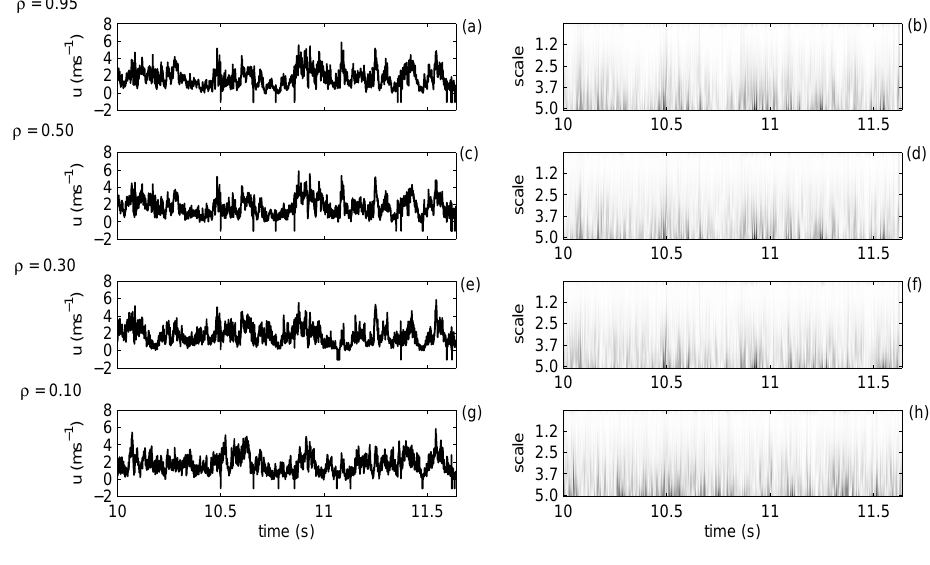
Fig. 3. Surrogate time series for the u 1 dataset from Fig. 1 are shown in the left hand column for stated values of ρ , while the right hand column gives the corresponding absolute part of the continuous wavelet transform for each surrogate series using a Mexican Hat wavelet applied to the first 5 scales (formed using 81 voices). Differences would be less visible if more scales had been displayed because the higher energy at higher j means that a greater proportion of coefficients are